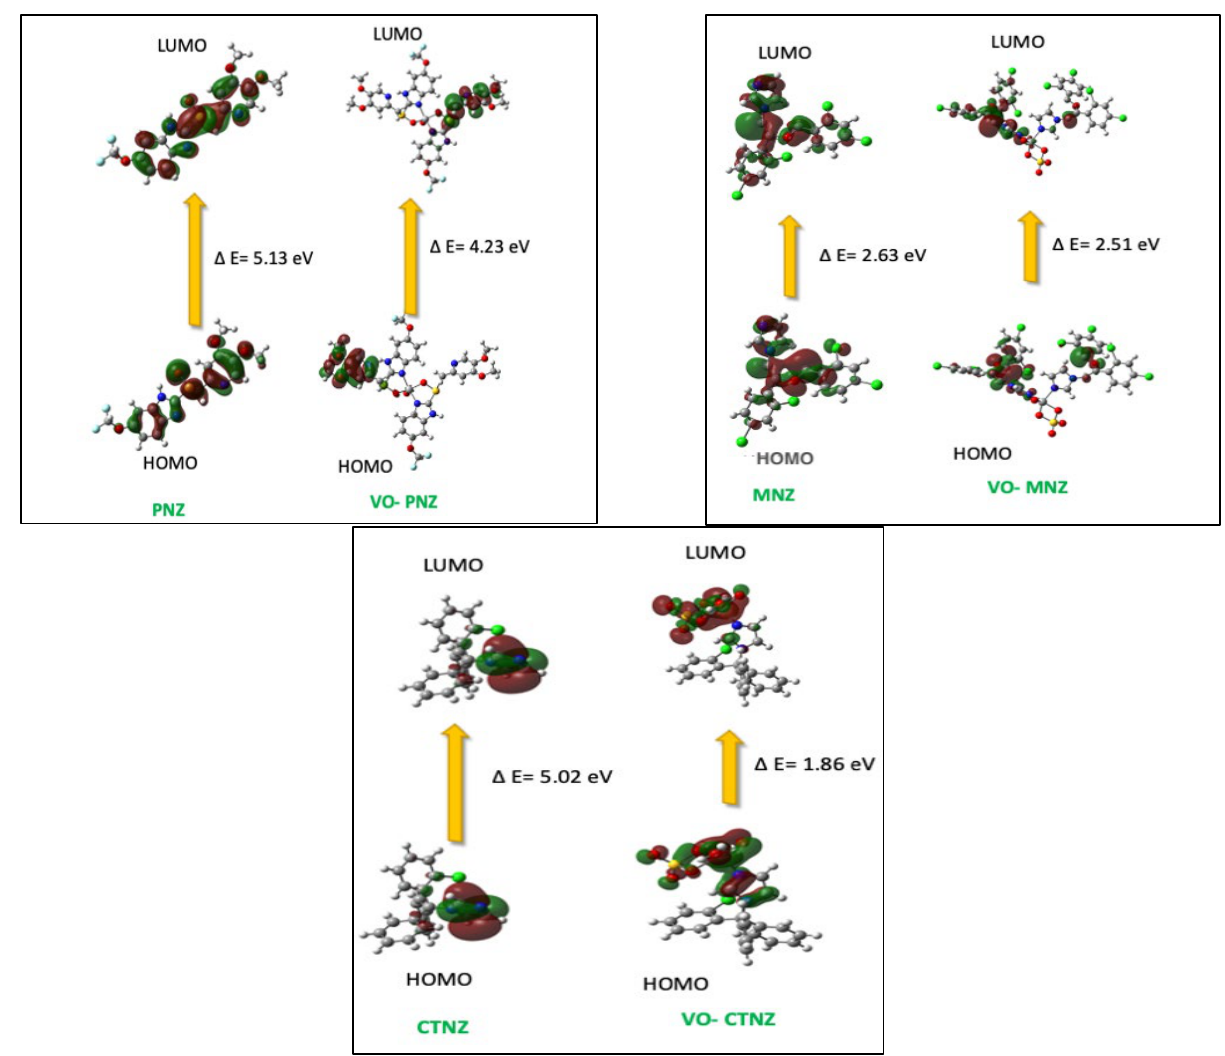
Figure 3. HOMO and LUMO charge density maps of the studied complexes using the